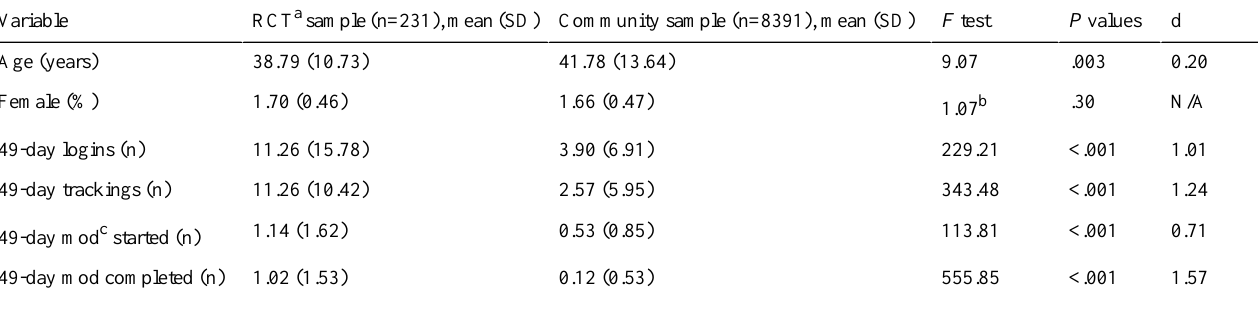
Table 1. Mean, SD, and between-group statistics on demographic information and usage behavior through 49 days